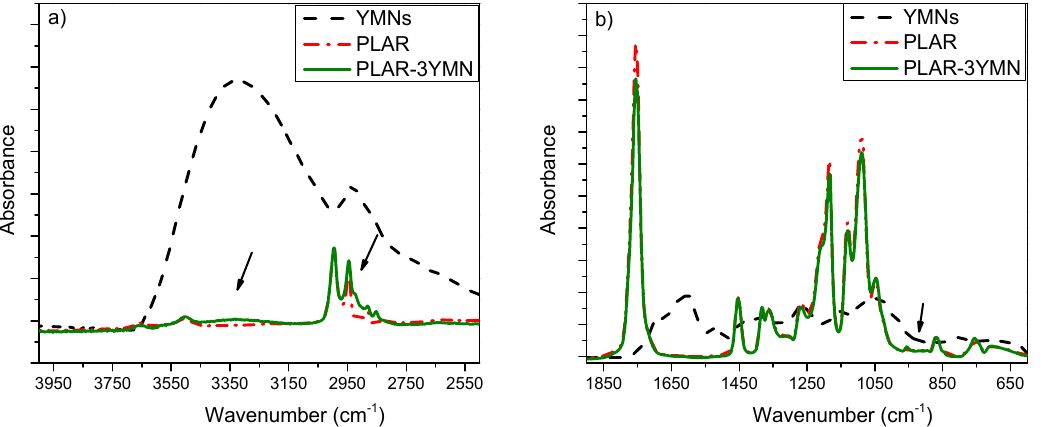
Figure 4. FTIR spectra of YMNs, recycled PLA (PLAR) and PLAR-3YMN bionanocomposite: ( a ) − 1 region and ( b ) in the 1900–600 cm − 1 region. in the 4000–2500 cm − 1 region and ( b ) in the 1900–600 cm − 1 region. 4000–2500 cm